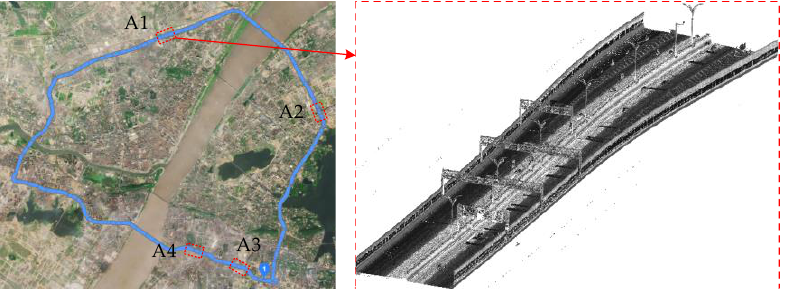
Figure 11. Experimental area and point clouds diagrammatic sketch of urban environment.